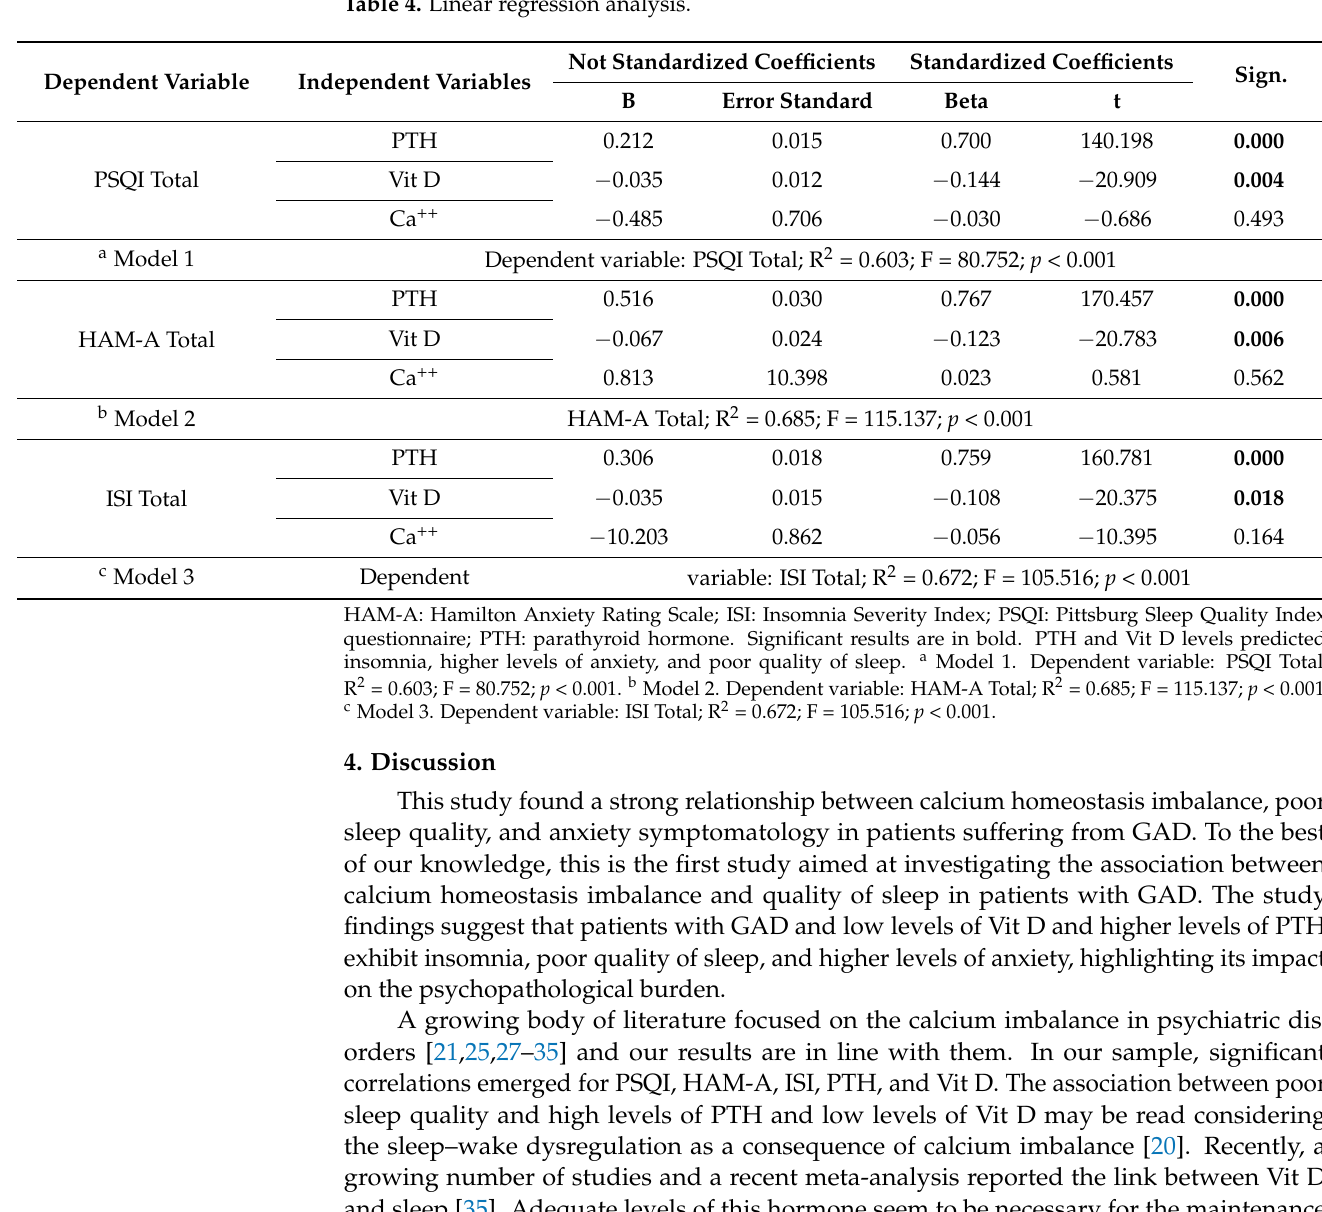
Table 4. Linear regression